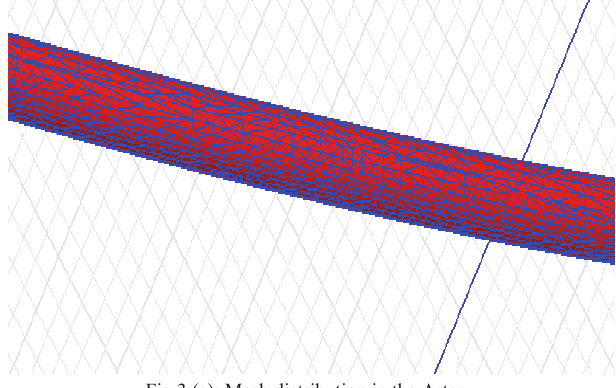
Fig.3 (c): Mesh distribution in the Artery Simulations were run at frequencies of 1 kHz, 5 kHz, 10 kHz, 50 kHz, 100 kHz, 150 kHz, 200 kHz, 250 kHz, 400 kHz, 500 kHz, 600 kHz, 700 kHz, 800 kHz, 900 kHz, 1 MHz, 1.25 MHz, 1.5 MHz, and 2 MHz. For each of these frequencies, three diameters of the artery were modelled as mentioned previously: 2.3 mm, 2.35 mm, and 2.4 mm.